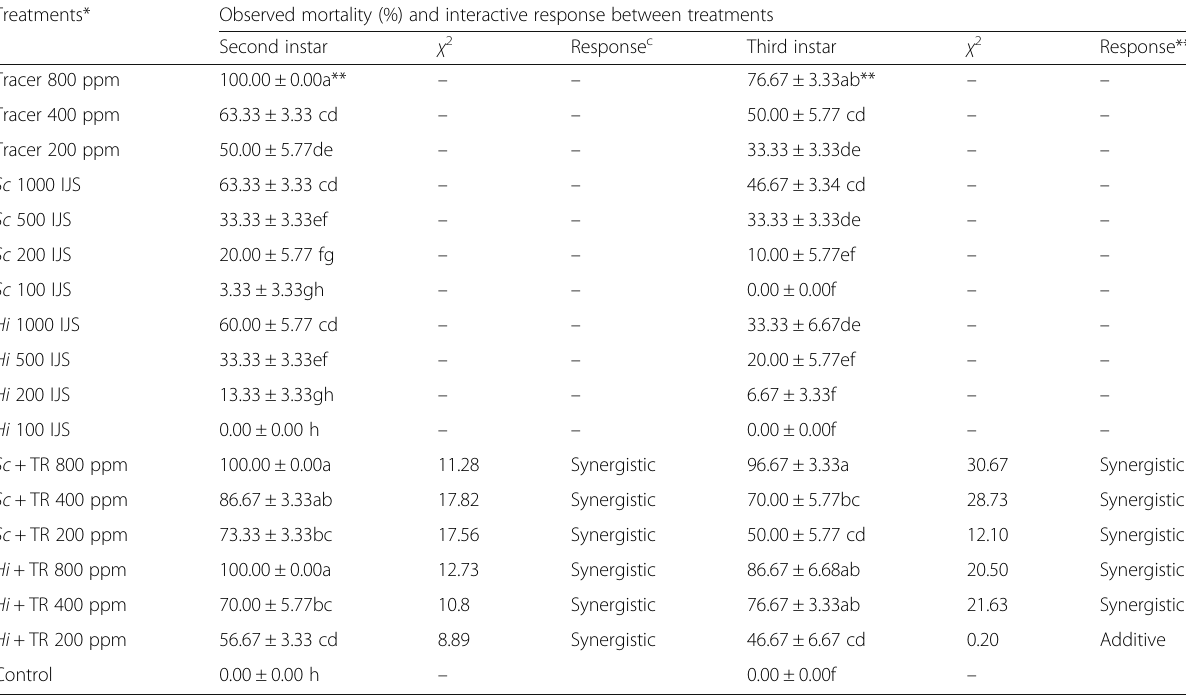
Table 4 Interaction between Tracer and entomopathogenic nematode species over mortality rate (mean ± SE) of the second and third larval instars of Spodoptera litura after 96 h of treatment application Treatments* Observed mortality (%) and interactive response between treatments